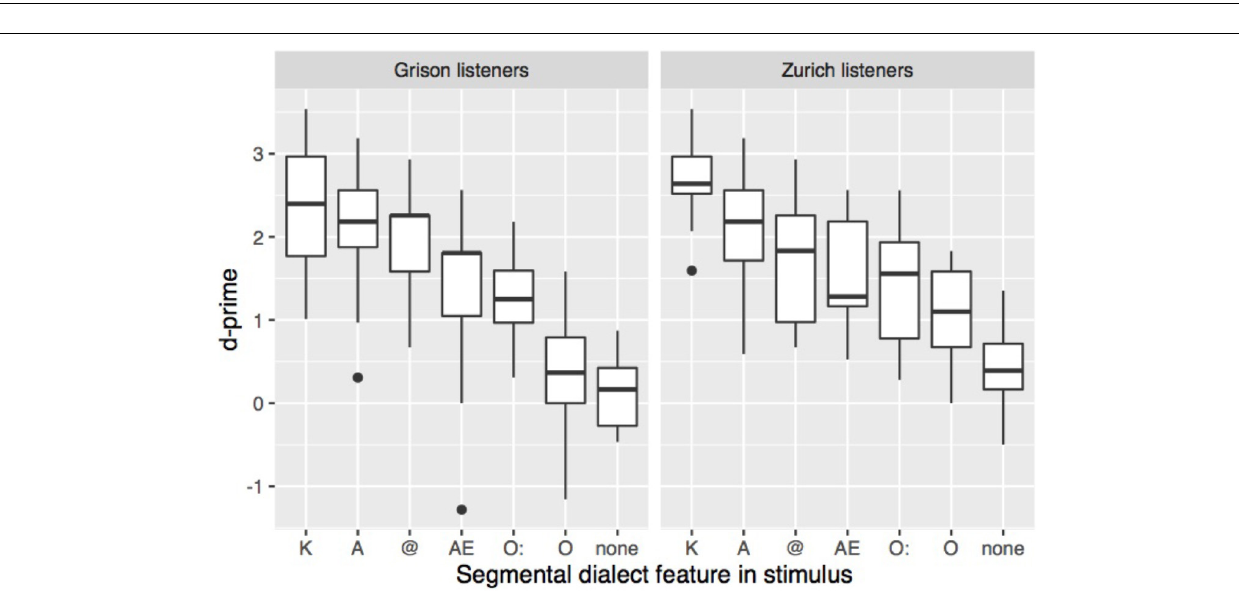
FIGURE 4 | Sensitivity according to the segmental dialect feature in the stimulus. Stimuli with two segmental dialect features have been discarded from this